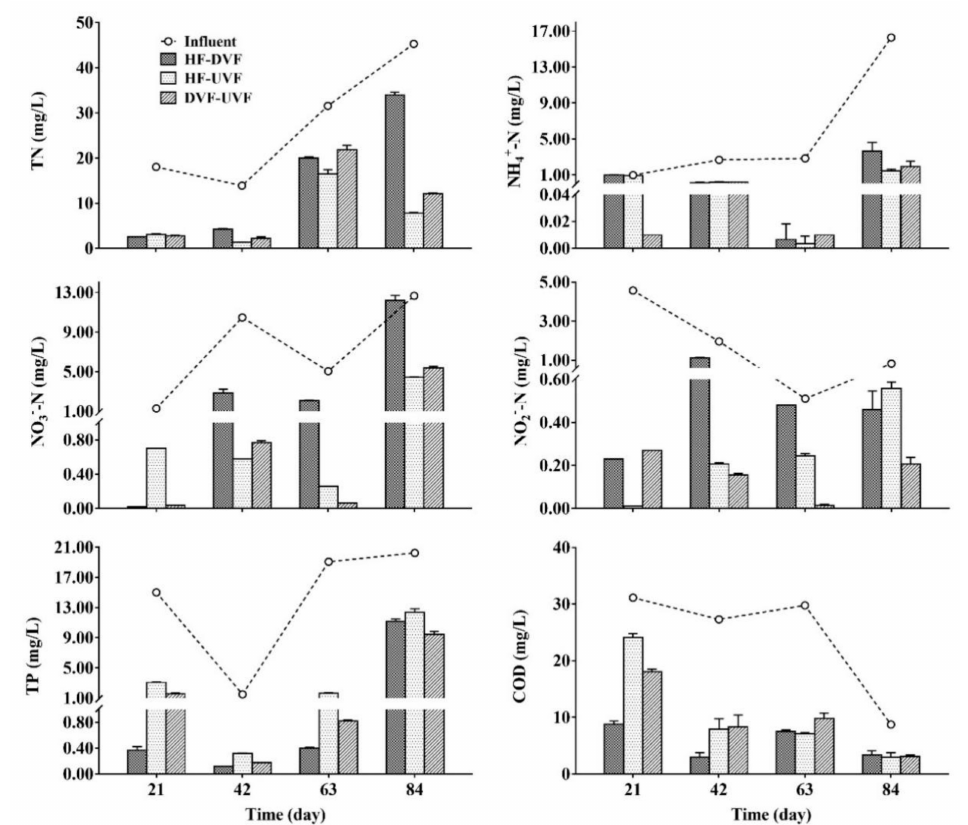
Figure 3. Nutrients concentrations in the influent and e ffl uent of di ff erent hybrid constructed